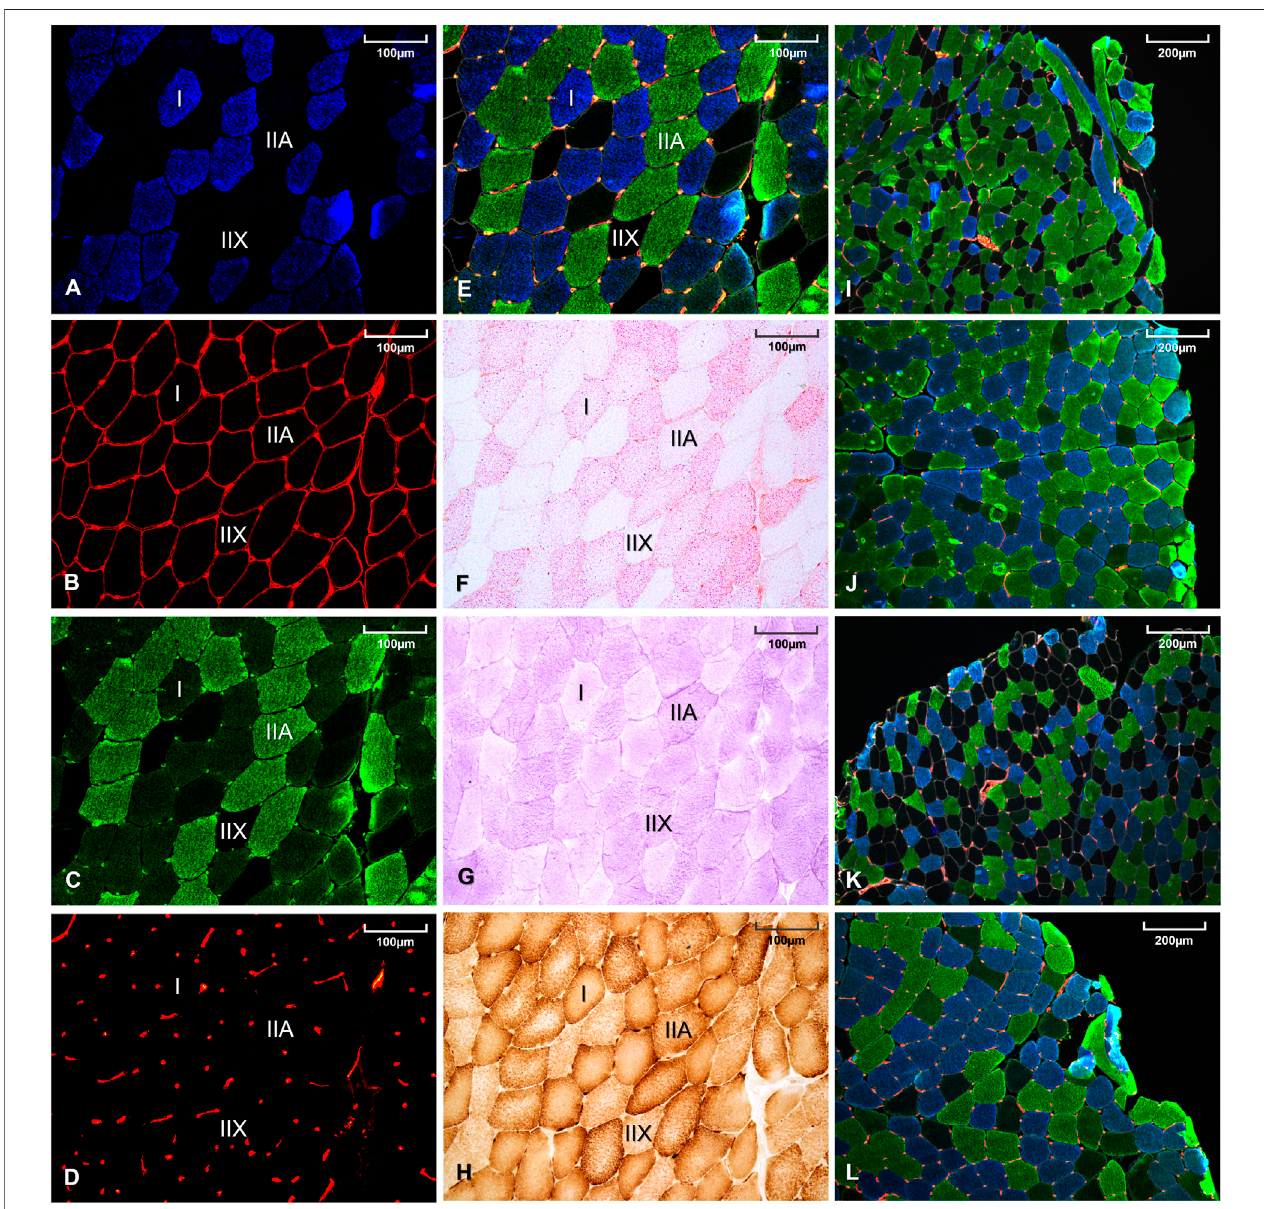
FIGURE 1 | Histological staining of a same muscle sample using BA-F8 primary antibody (A) , 2E8 primary antibody (B) , BF-35 primary antibody (C) , anti-CD31- JC70A primary antibody (D) , merge of (A – D) images (E) , oil red O staining (F) , periodic acid Schiff staining (G) , diaminobenzidine staining combined with cytochrome-c oxidaseactivity (H) .Representativemusclesamplefromawomenwithconstitutionalthinness (I) ,anormalweight women (J) ,amenwithconstitutionalthinness (K) and a normal weight men (L) .